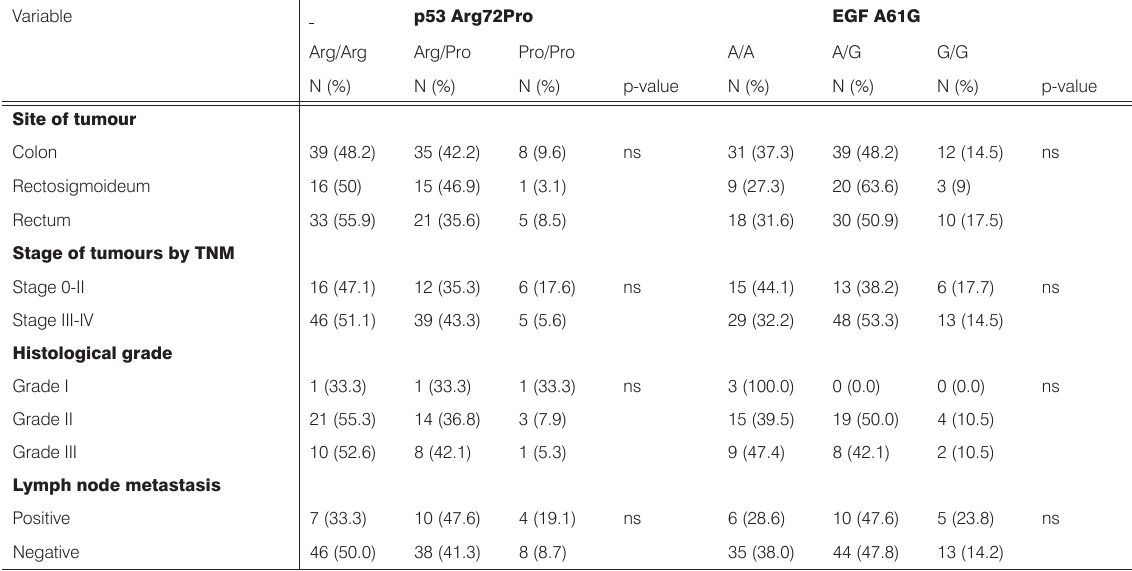
Table 2. Associations between the p53 Arg72Pro or EGF A61G polymorphism and clinical characteristics.